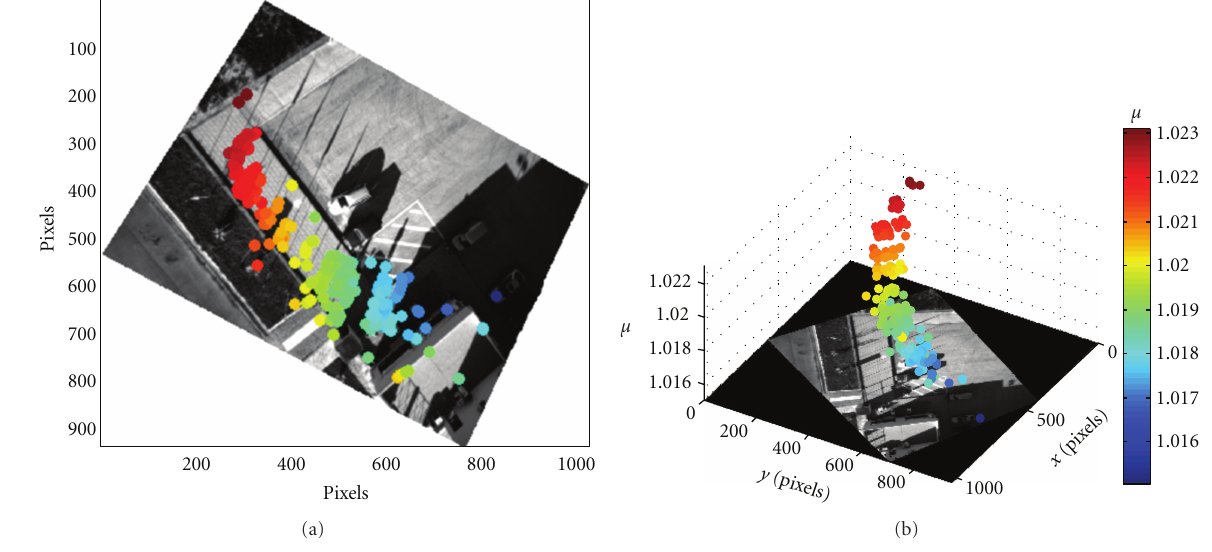
Figure 11: The μ values for individual pixel correspondences.